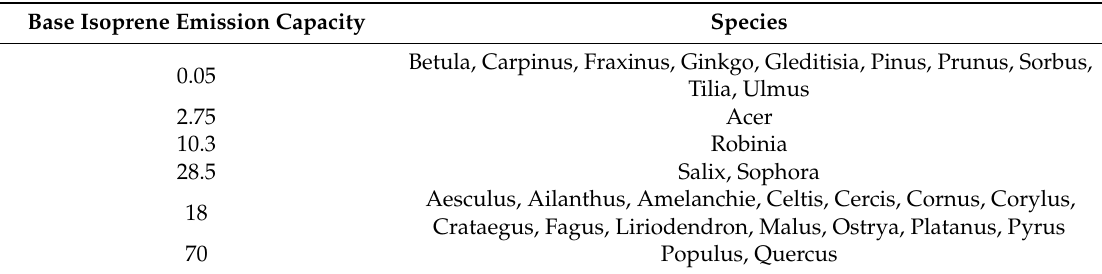
Figure 4. ( a ) Standard classification of vehicle types for a mid-sized European town used for the simulations and ( b ) predefined diurnal profile of NO/NO 2 emissions used for the simulations [65]. Table 4. Tree types taken from a current tree inventory (2018) from the city of Mainz classified in 6 different classes according to their base isoprene emission capacity.